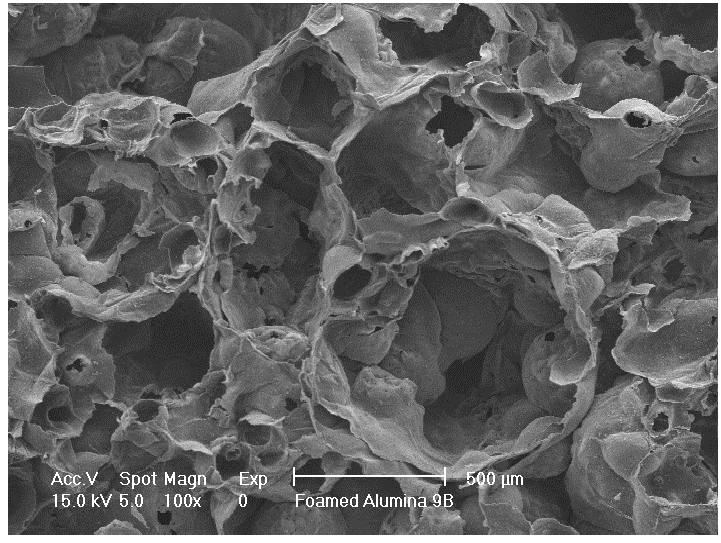
Figure 2. Scanning electron microscopy (SEM) of sintered porous